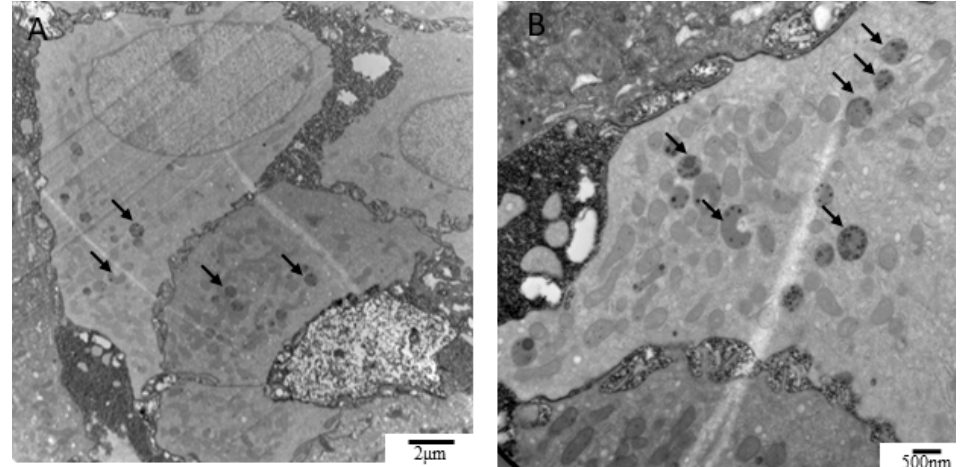
Figure 3. EM evidence revealed IBCs in the human rUTI bladder biopsy specimens. ( A , B ) IBCs were detected in the uroepithelial cells in the patients with rUTI who had recovered from an acute UTI episode, suggesting that bacterial incubation leads to UTI recurrence in patients.